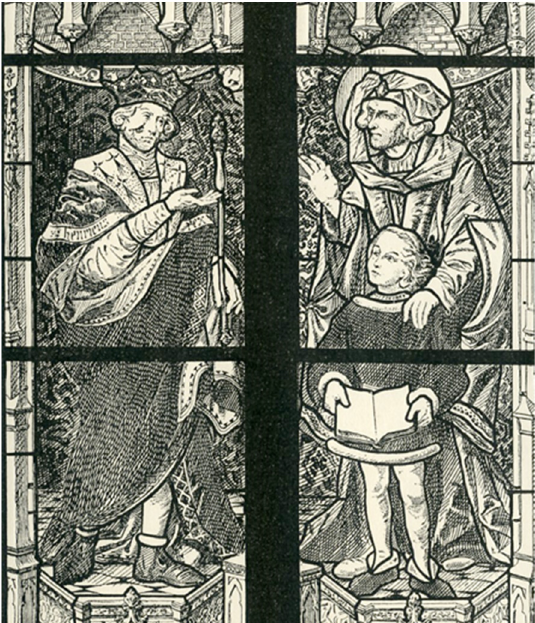
Figure 8. Saint-Lô, Church of Notre-Dame, Saint-Thomas chapel, Life of Saint Thomas window, 1898, detail, Henry II charges Thomas with the education of Prince Henry. © unknown (image in the public domain).